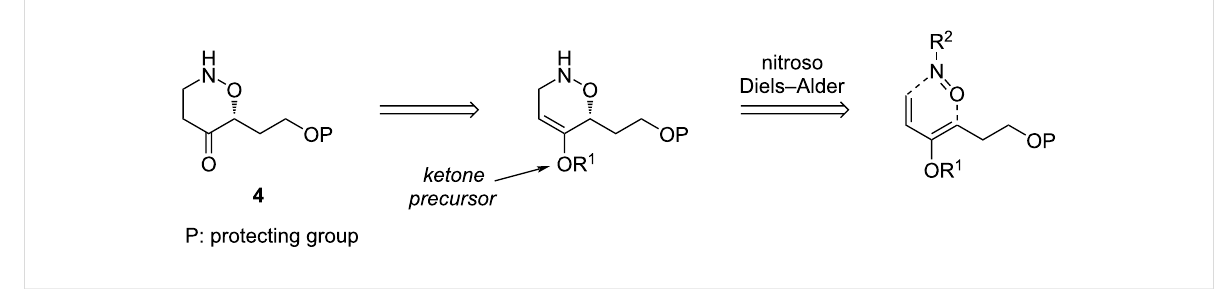
Figure 3: strategy for the synthesis of central fragment 4 : nitroso Diels–Alder reaction.